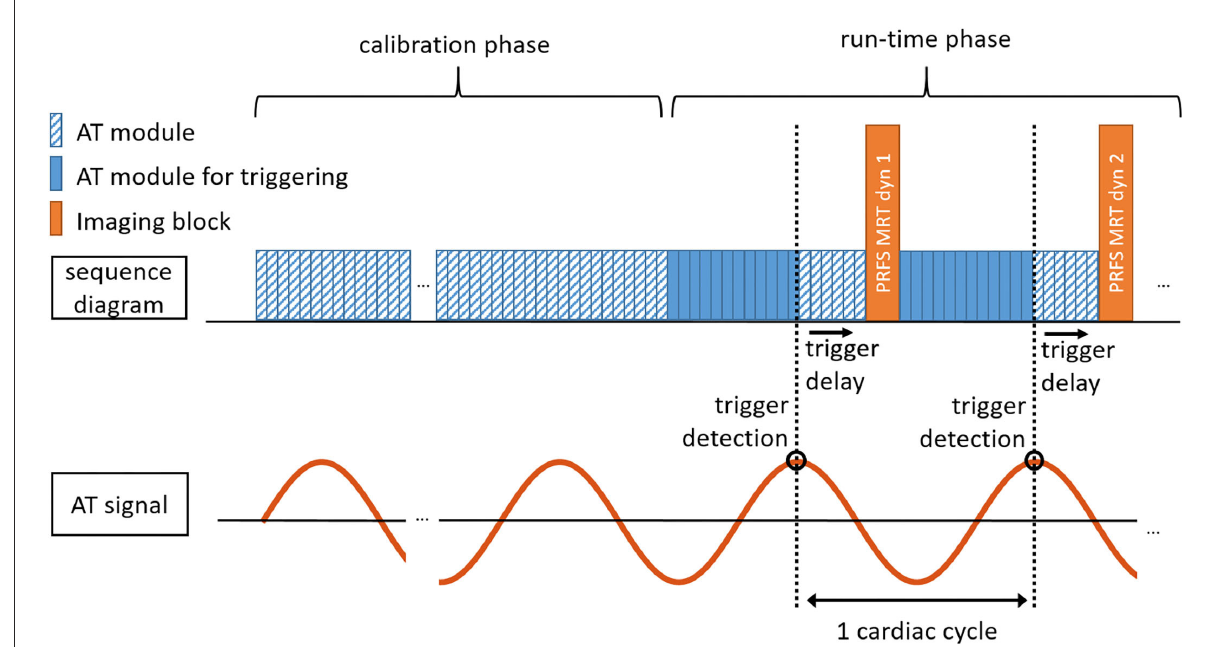
FIGURE1 Schematic diagram of AT-triggering-based MR thermometry. After a calibration phase to characterize the AT signal (duration: 16s), the sequence automatically proceeds to the run-time phase in which MR thermometry is performed in synchronicity with the cardiac cycle through repeated measurements of the AT signal. During each imaging block (dynamic image number 1, 2, etc.), all prescribed slices are acquired following a shared trigger. PRFS, Proton resonance frequency shift; MRT, MR thermometry; dyn, dynamic image number; AT module